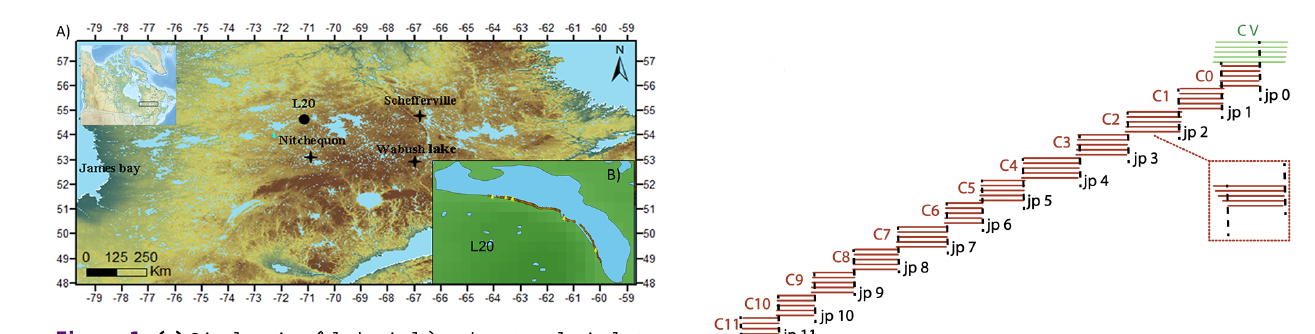
Figure 1. (a) Site location (black circle) and meteorological sta- tions (black stars). (b) Representation of lake L20, also illustrating the sampling location of subfossil stems (brown marks) and living trees (yellow marks).